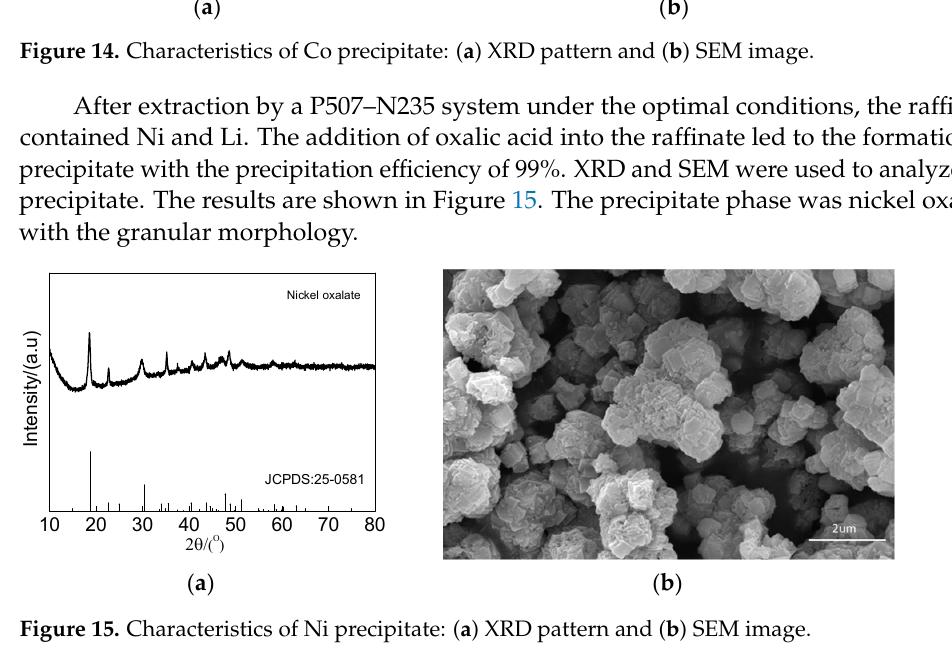
consisted of granular particles.